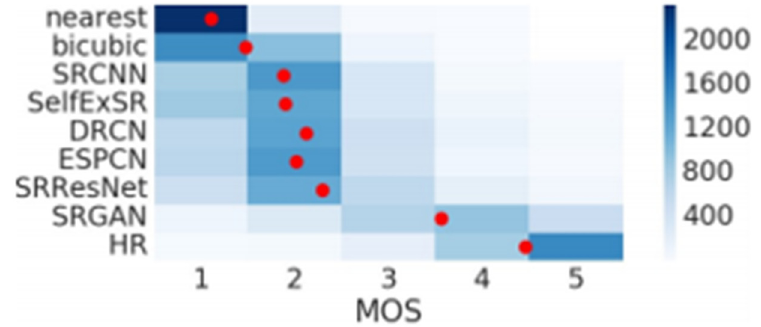
Figure 16. Color-coded distribution of MOS scores on BSD100. For each method 2600 samples (100 images × 26 raters) were assessed. The mean is shown by the red markers, where the bins are centered around value i (4 × upscaling).